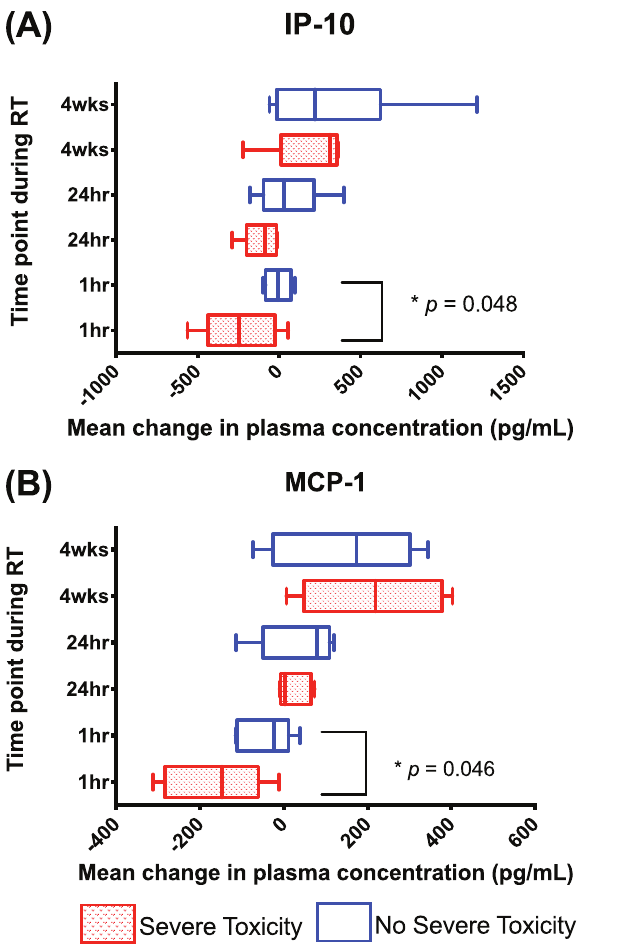
Figure 5. Box and Whisker plot demonstrating median population change of cytokine levels from baseline for IP-10 and MCP-1 during treatment delivery, with 5 th –95 th centiles. Statistically significant differences between patients with severe respiratory toxicities [shaded boxes] and those without [open boxes] are highlighted with associated p - values.